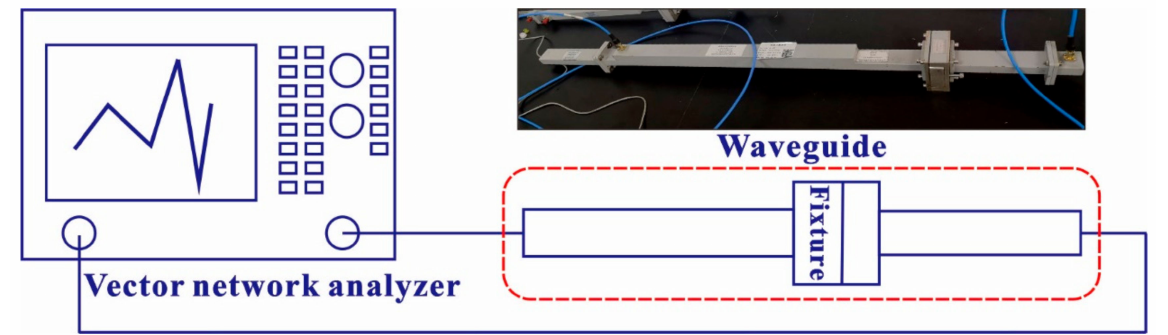
Figure 3. Test equipment of the